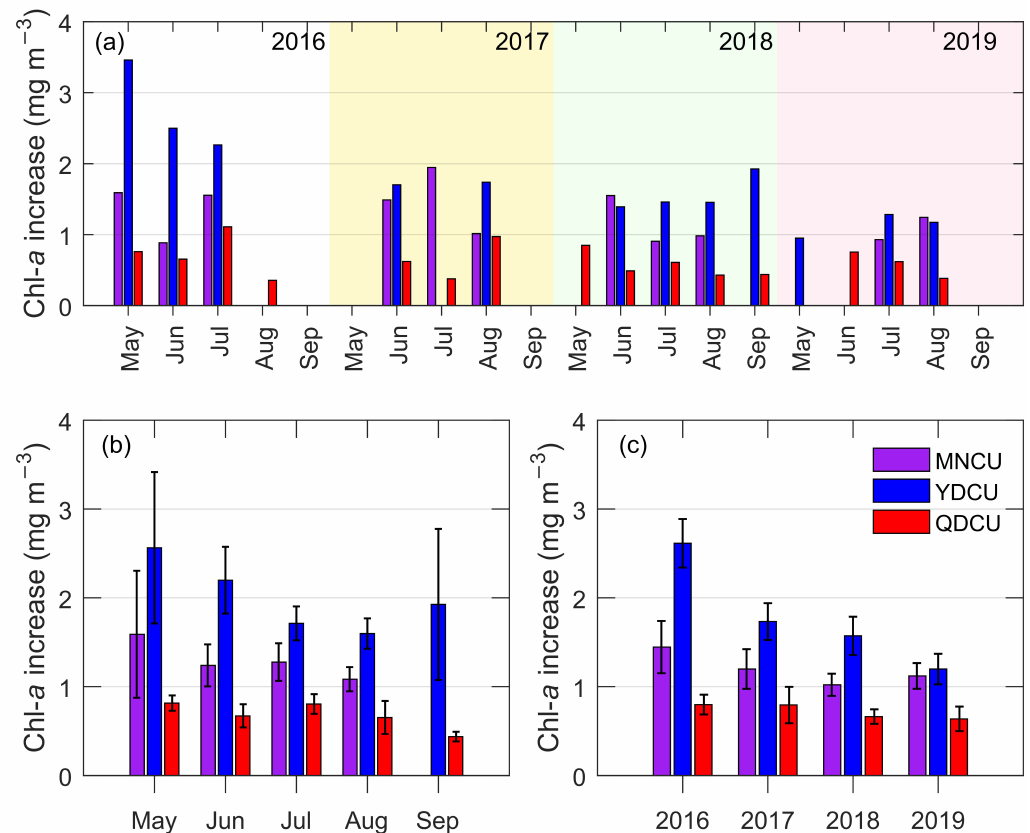
Figure 10. The inter-monthly and the inter-annual variations of the coastal upwelling’s Chl- a increase (unit: mg m − 3 ) in the NSCS from 2016 to 2019. ( a ) The monthly mean of upwelling’s Chl- a increase for the individual years 2016, 2017, 2018, and 2019; ( b ) the monthly mean of the upwelling’s Chl- a increase regardless of the year; ( c ) the annual mean of the upwelling’s Chl- a increase. The error bars in ( b , c ) are 95% confidence